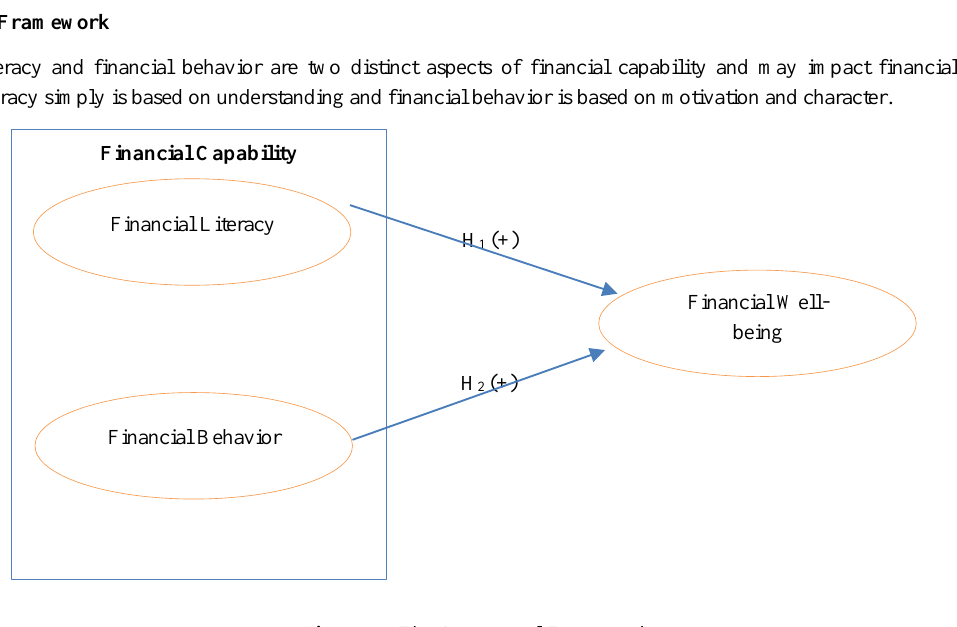
Figure 1: The Conceptual